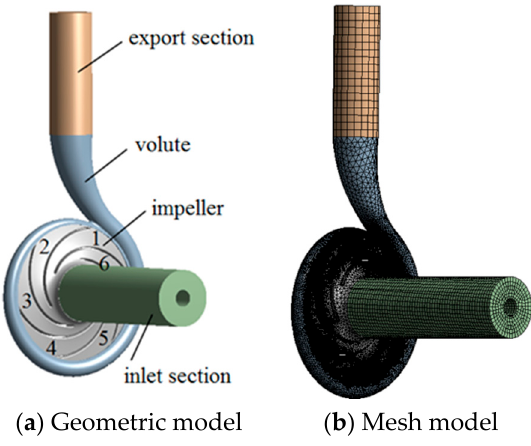
Figure 1. Three-dimensional model and mesh model of the centrifugal pump.